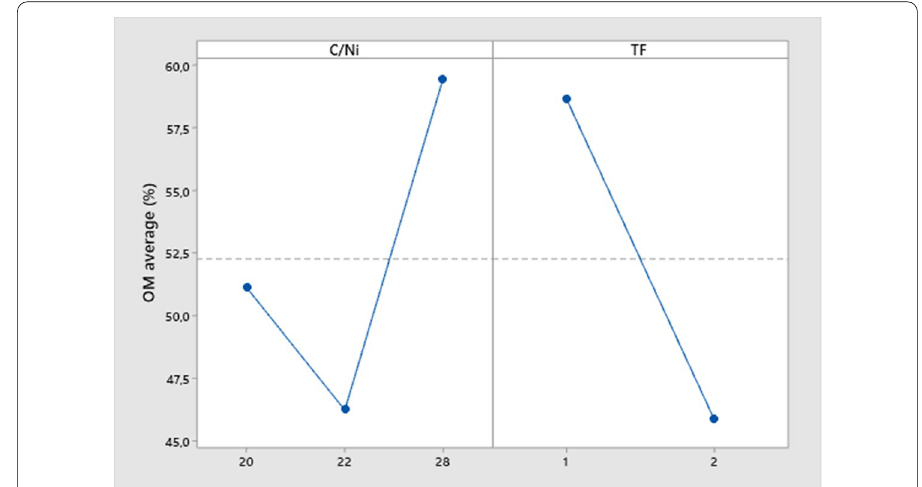
Fig. 7 Effect diagram of C/Ni and TF on OM